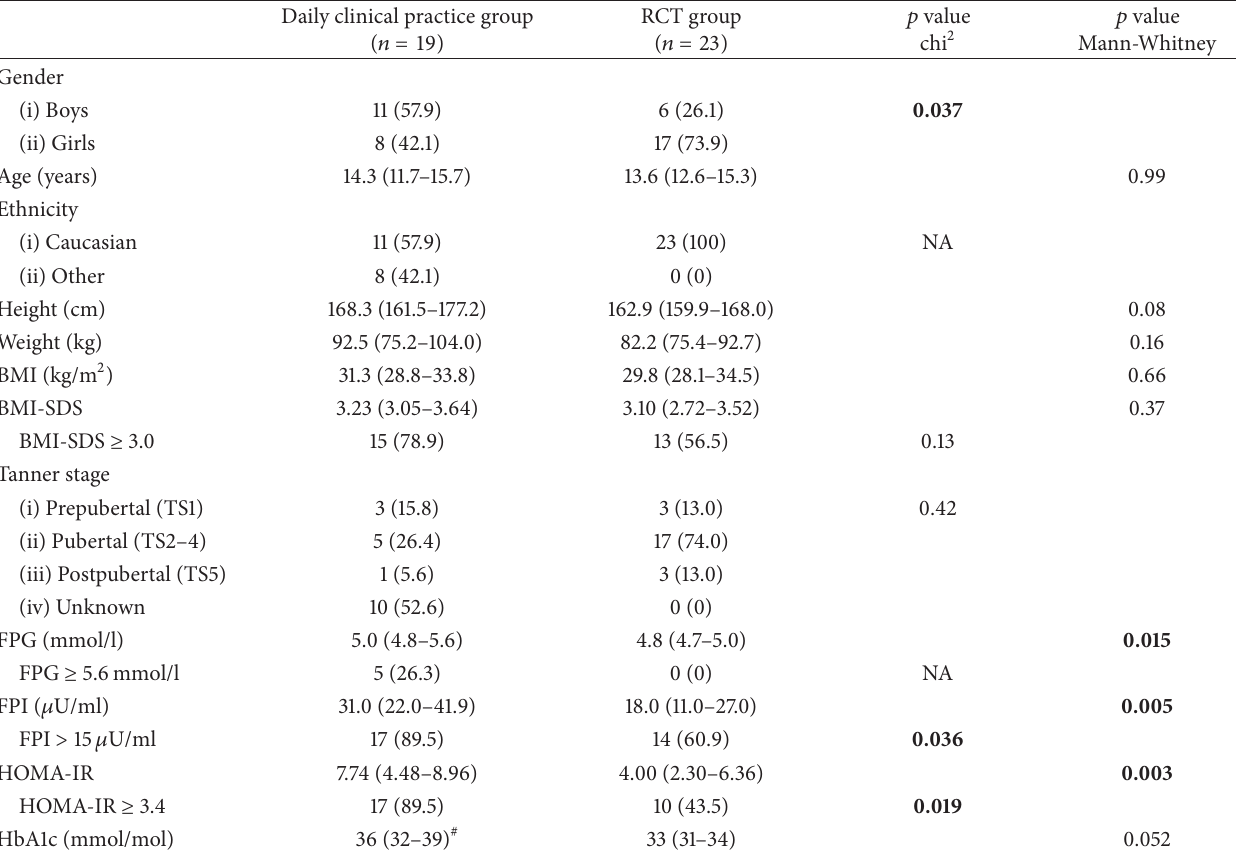
Table 1: Baseline characteristics of patients treated with off label metformin and treated with metformin in a randomized clinical trial.